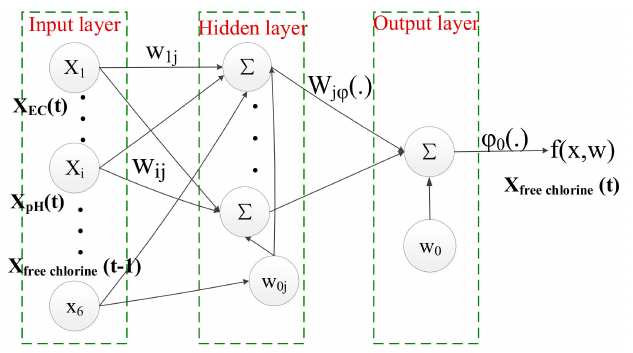
Figure 4. BP (Back Propagation) neural network structure of free chlorine.